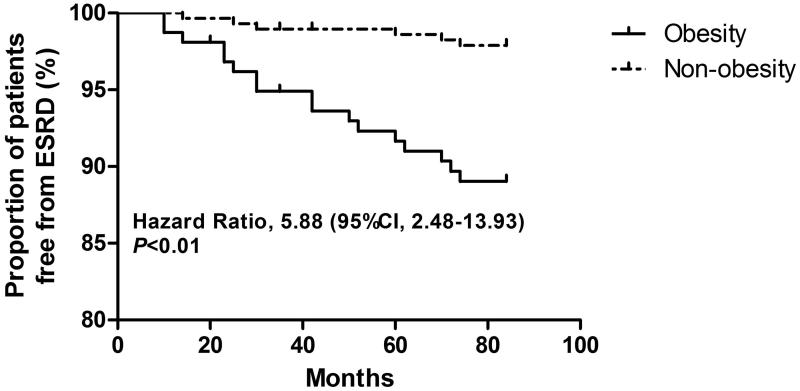
Kaplan–Meier curves of end-stage renal disease (ESRD) stratified by obesity in patients with Henoch-Schönlein Purpura (HSP).